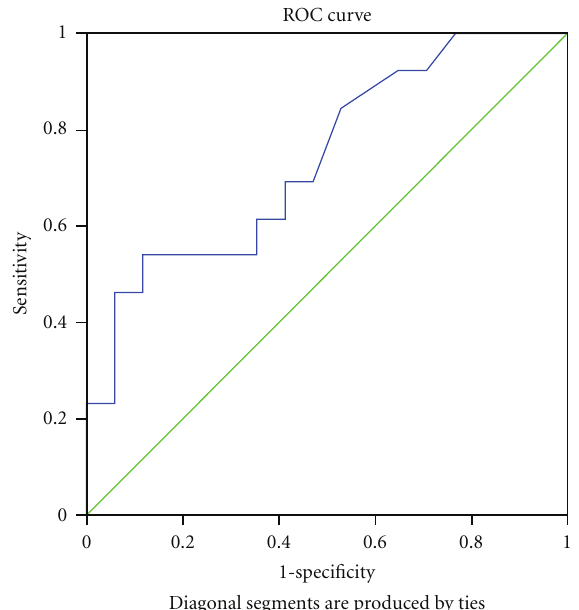
Figure 1: ROC curve—DPP at 18-month visit in progressing glaucoma patients. ROC: Receiver operating characteristic.